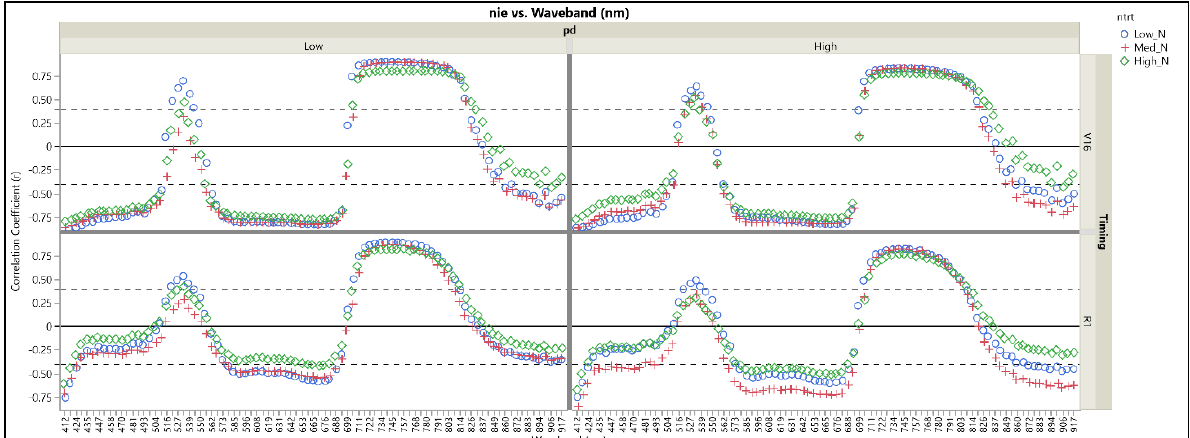
Figure 3. Pearson product-moment correlations (r) for NCE at R6 (kg/kg N) by waveband (nm) from images at V16 (upper block) or R1 (lower block) for low and high planting density (pd) colored shape by N treatment (Low N = blue circle, Med N = red plus, High N = green diamond). Black lines are for reference only: solid line is at r = 0 and dashed lines at r = |0.4|.